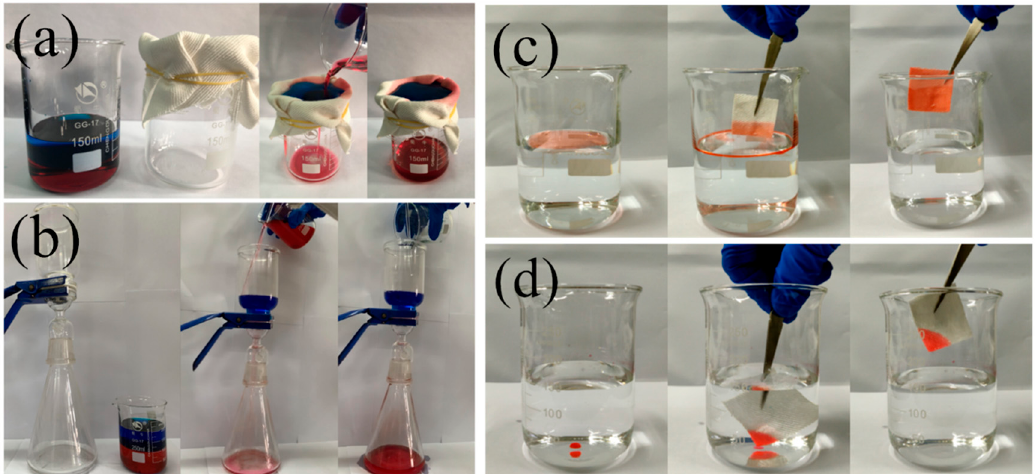
Figure 11. Application of superhydrophobic fabric to separate oil and water: ( a , b ) carbon tetrachloride (dyed with oil red O) and water (dyed with methyl blue), ( c ) selective absorption of superhydrophobic cotton for cyclohexane (dyed with oil red O) in water and carbon tetrachloride (dyed with oil red O) in water ( d ).